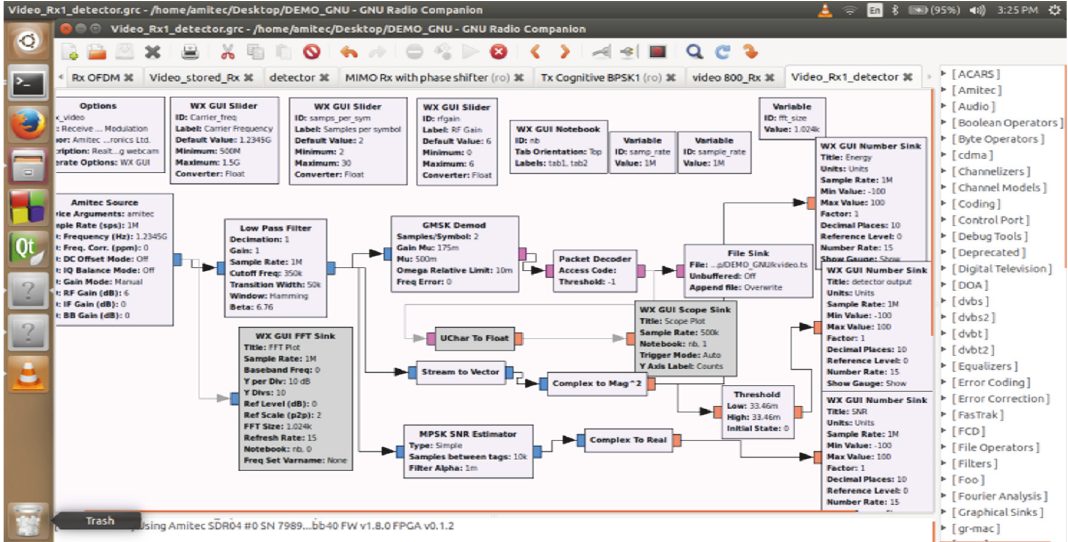
Figure 6: Receiver side flow graph for video reception and detection of signal designed using GNU